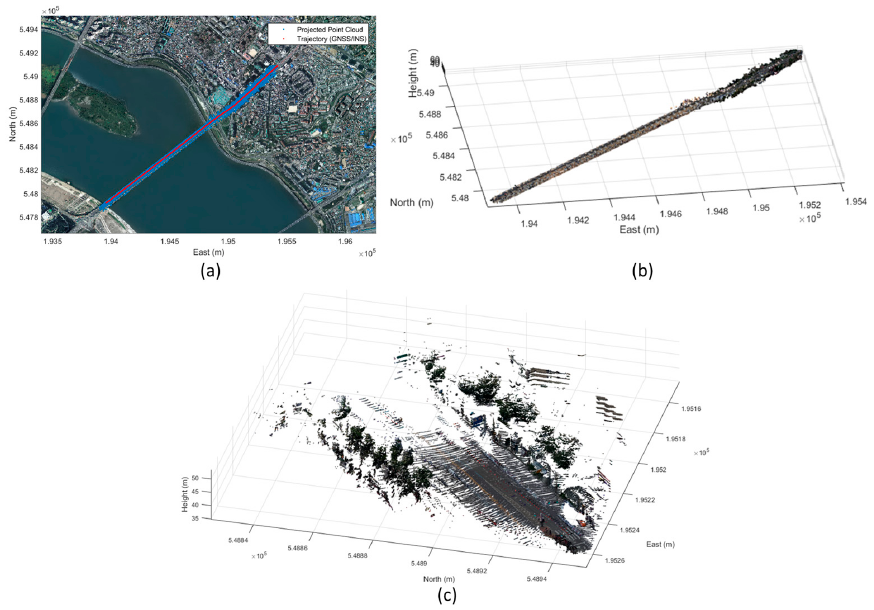
Figure 17. Point cloud generated by developed MMS: ( a ) point cloud projected on aerial orthophoto; ( b , c ) point cloud including color information.